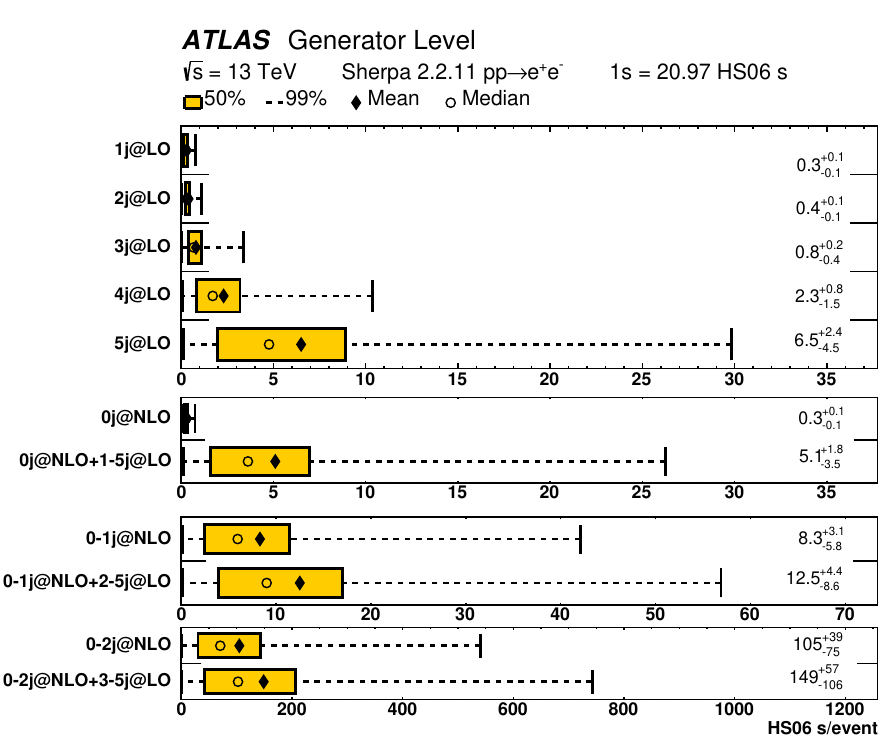
Figure 7 . The time in HS06 seconds per event for various configurations that vary the QCD accuracy of the sample and number of extra partons. The markers show the mean and median values, and the box shows the ± 25% quantiles. The whiskers show the 99% containment bounds, while the numbers on the right show the mean and standard deviation of the sample. Each canvas has a different x -axis range. One second equals 20.97 HS06 seconds on the specific machine